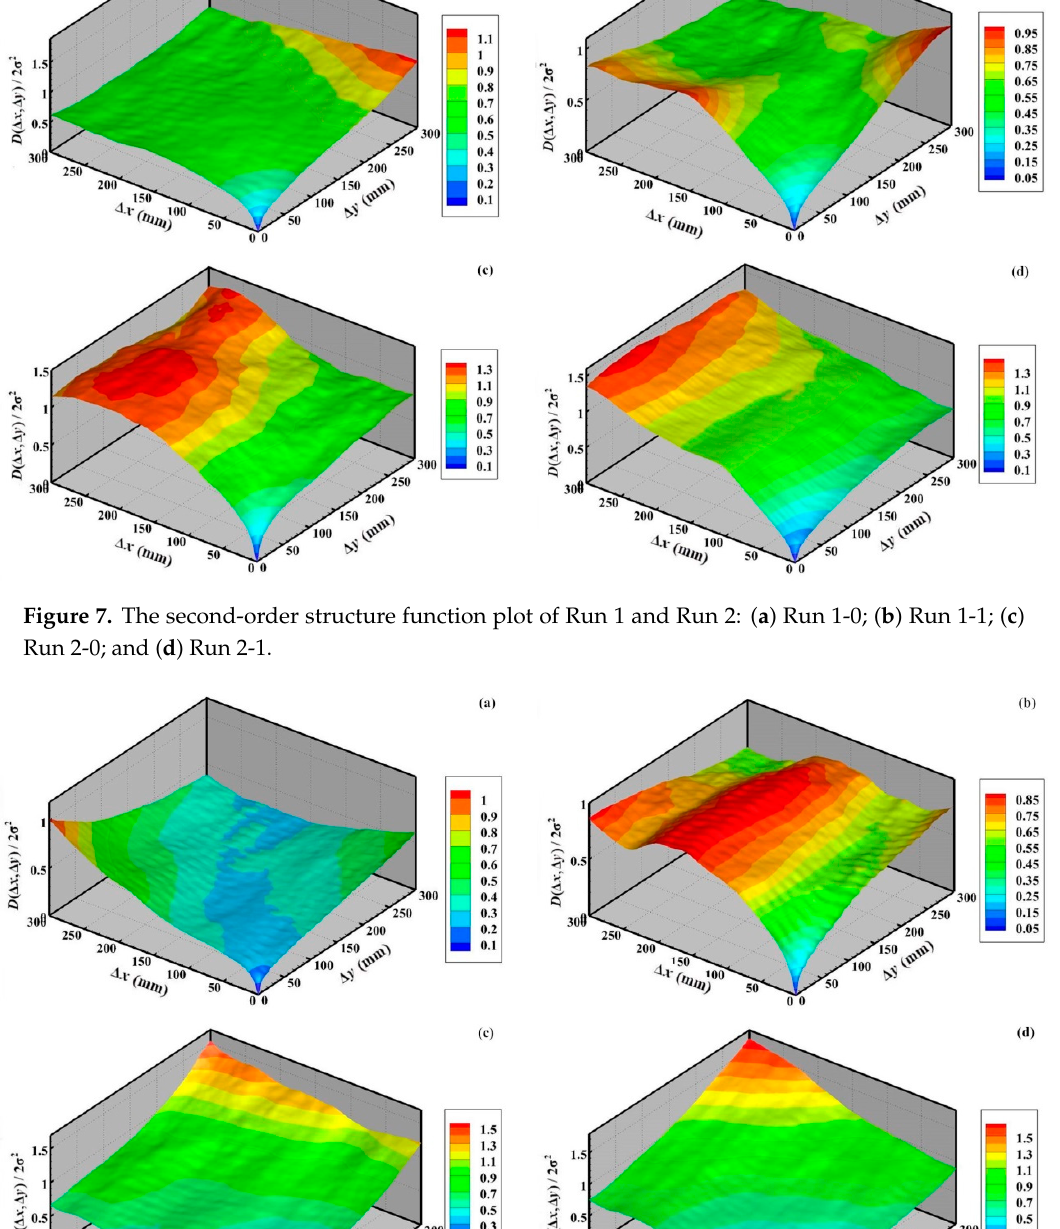
Figure 6. The second-order structure function plot of initial bed materials.